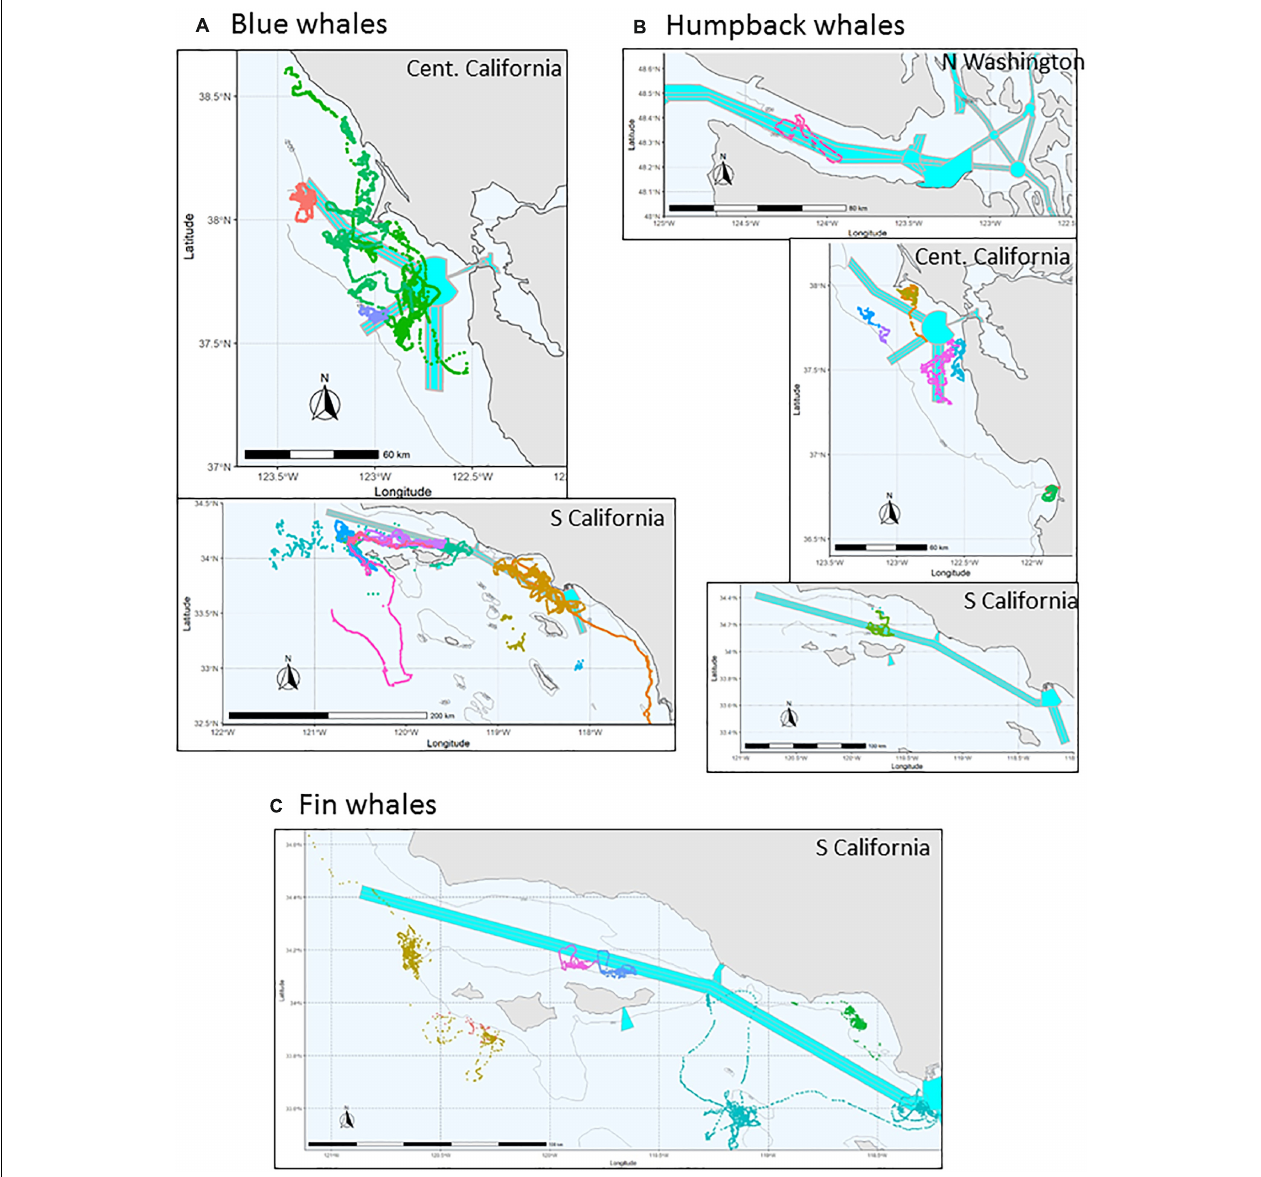
FIGURE 1 | Map of position tracks by species (color coded by deployment) for tag deployments used in this analysis. (A) Blue whale, (B) Humpback whale, and (C) Fin whale.